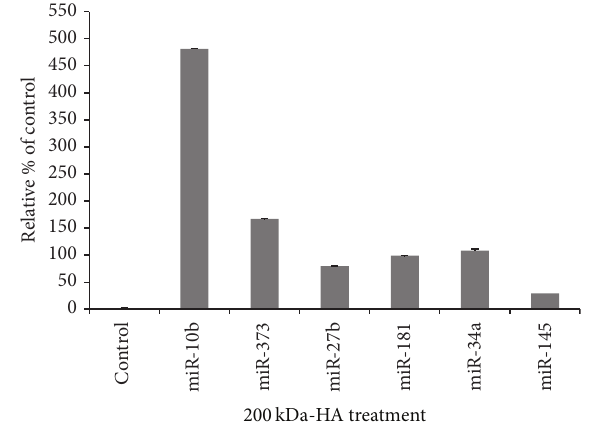
Figure 5: Comparison of miR-10b expression with various other miRNA productions in CD 44 v 3 high ALDH high cells following the treatment with different sizes of HA (e.g., 5 kDa-HA, 20 kDa-HA, 200 kDa-HA, 700 kDa-HA, and no HA) and analyzing by Q-PCR as described in Section